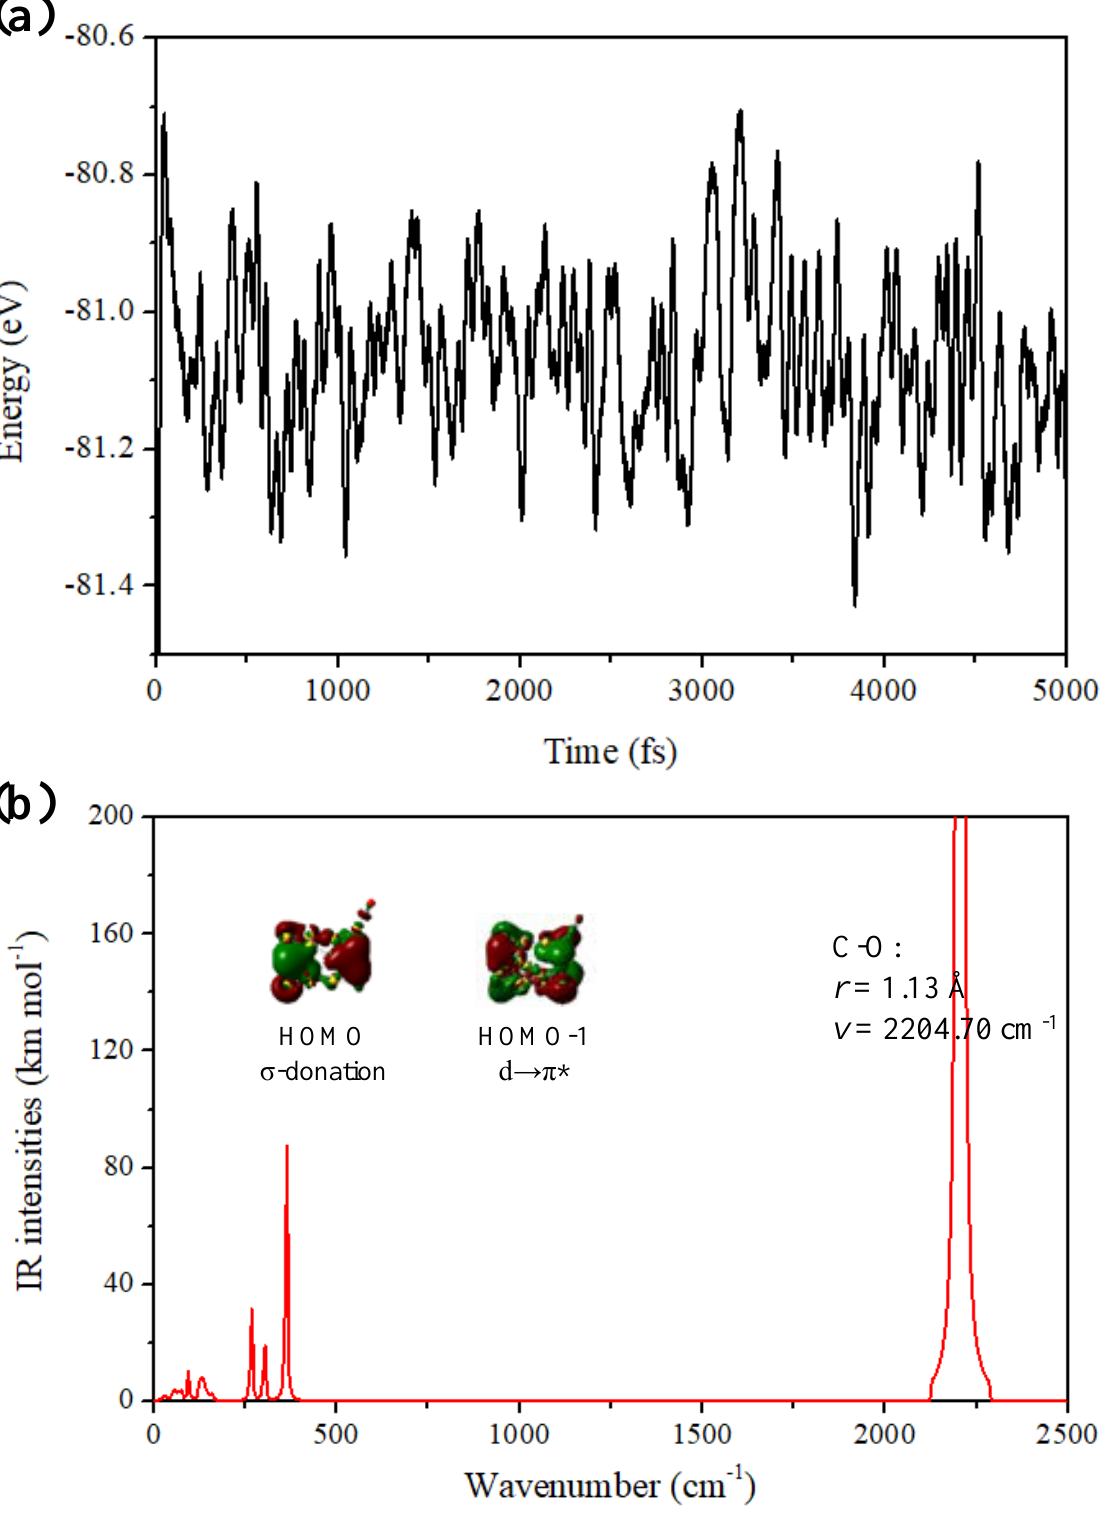
Figure 2. ( a ) The energy fluctuation with the time step at 500 K, ( b ) infrared spectrum and molecular orbitals of iso1 structure of the Au 26 - CO.